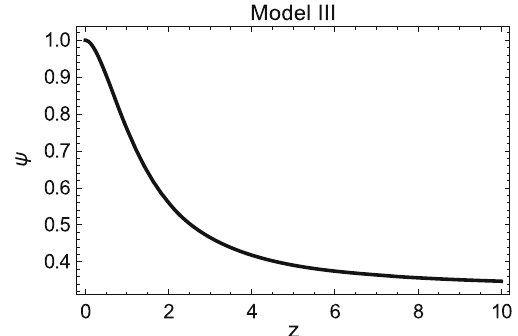
Fig. 4 Plot of the quintessence scalar field ψ with redshift for Model I I